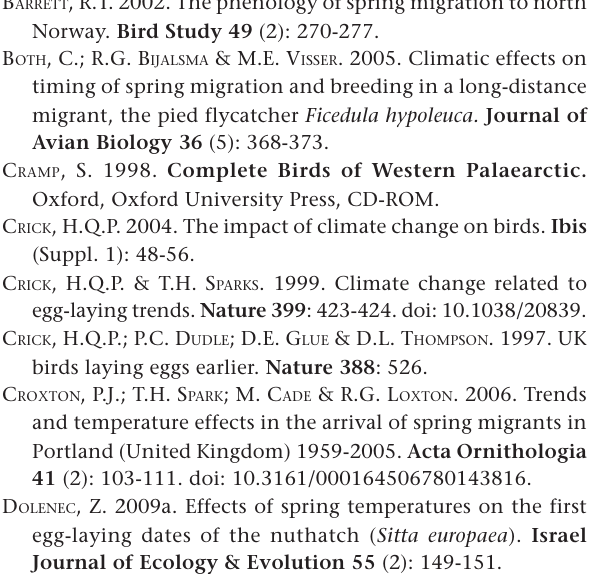
Figure 1. Temporal trends in first arrival dates of the House Martin D. urbica in north-western Croatia, 1981-2008 (1 = 1 March).